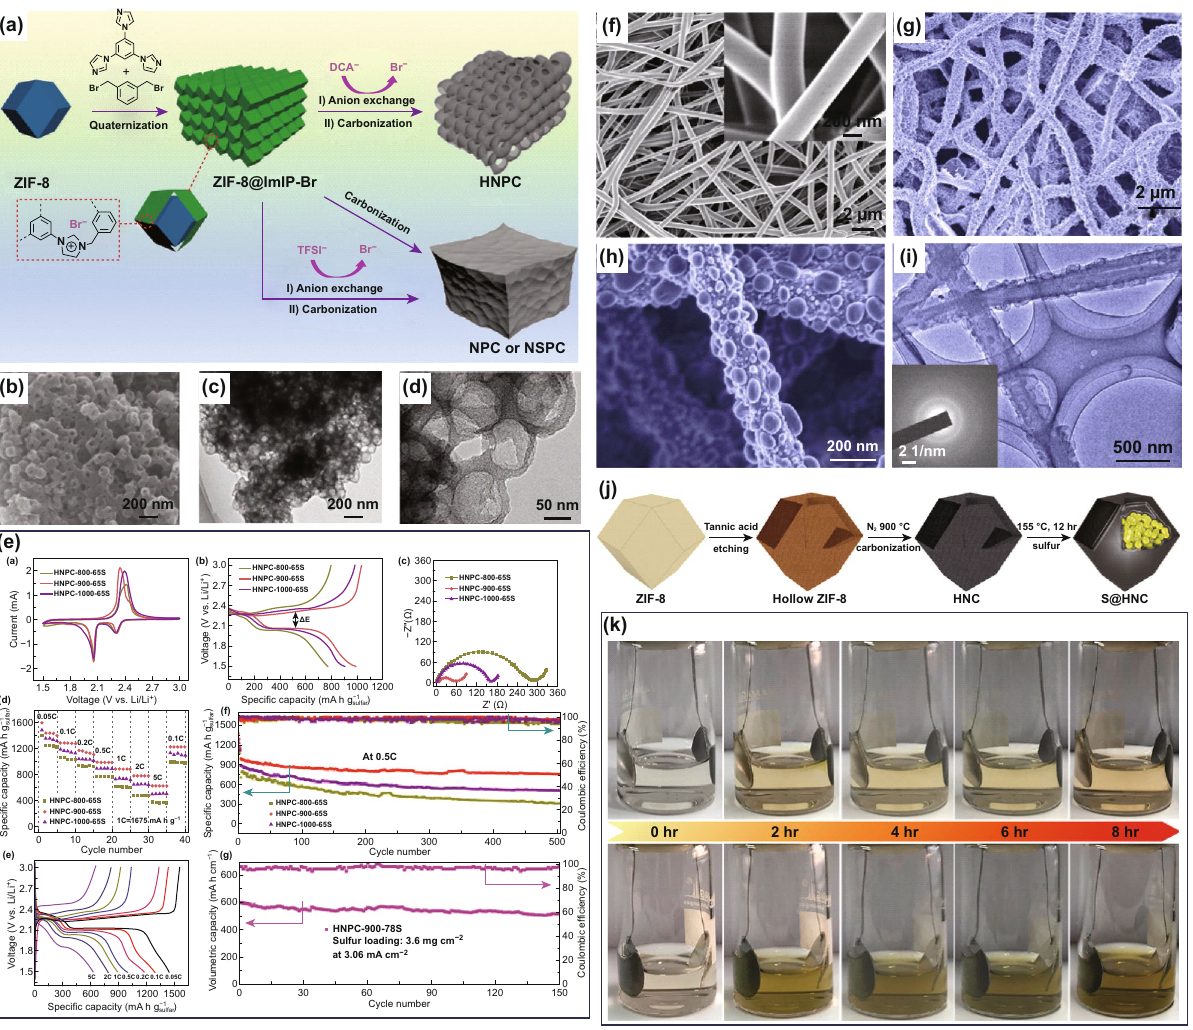
Fig. 11 a Schematic illustration of the synthesis route for HNPC. b SEM image and c , d TEM images of the HNPC-900. e Electrochemical performance of HNPC electrodes for LSBs. Reproduced with permission from Ref. [165]. Copyright 2019, Wiley–VCH. f SEM images of the electrospun PVA-LiN 3 nanofibers. g , h SEM images of PCNFs after calcination. i TEM image of the CHNBs@PCNFs. Reproduced with per- mission from Ref. [206]. Copyright 2018, Elsevier. j Schematic illustration of the synthesis process for S@HNC hybrid. k Digital images of S@ HNC and S-NC electrodes during the discharge process for LSBs. Reproduced with permission from Ref. [168]. Copyright 2019, Cell Publish- ing